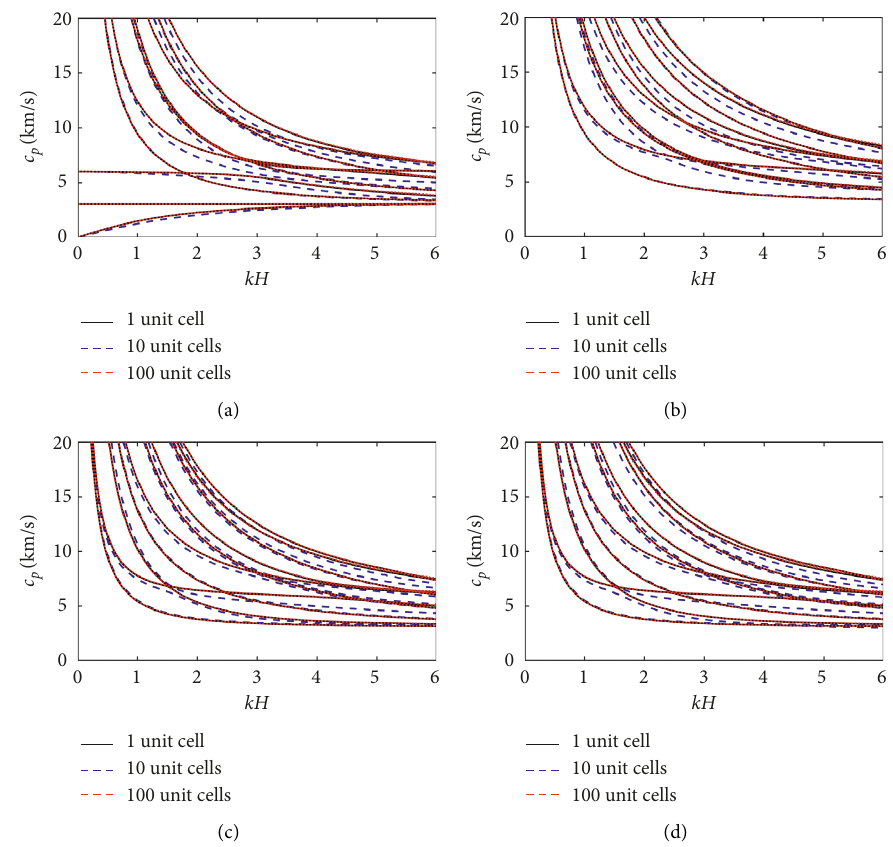
Figure 8: Dispersion curves of guided waves in the periodic plates with 1 unit cell (dashed curves), 10 unit cells (solid curves), and 100 unit cells (dotted curves) under the four types of boundaries: (a) FOO-FOO, (b) COO-COO, (c) CSS-FOO, and (d) CSS-FSS.